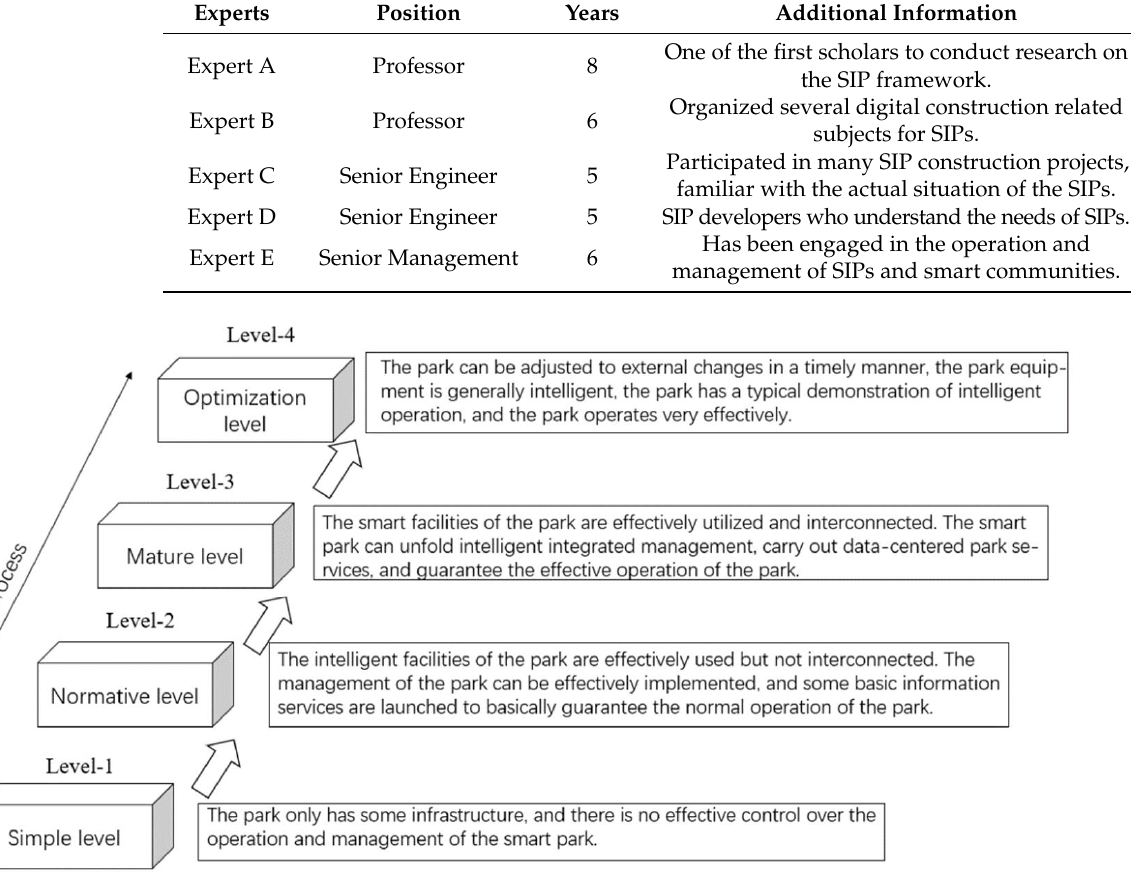
Table 2. Composition of experts.